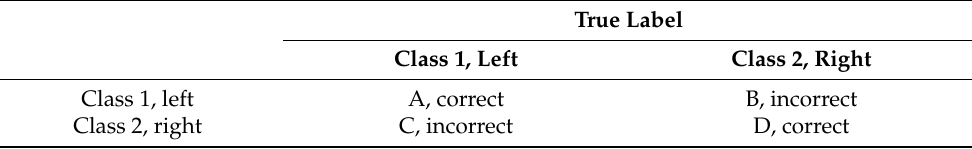
Table 2. Comparison of predicted and true classifications for left and right hands.